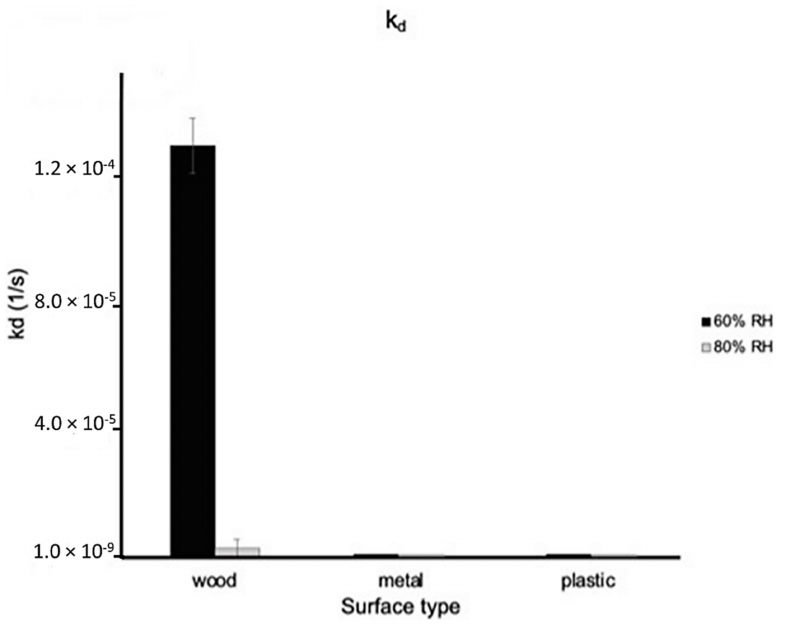
Figure 10. Dissociation constants (k d ) of wood, metal, and plastic swab surface samples at 60% and 80% relative humidity (Table S3 in Supplementary